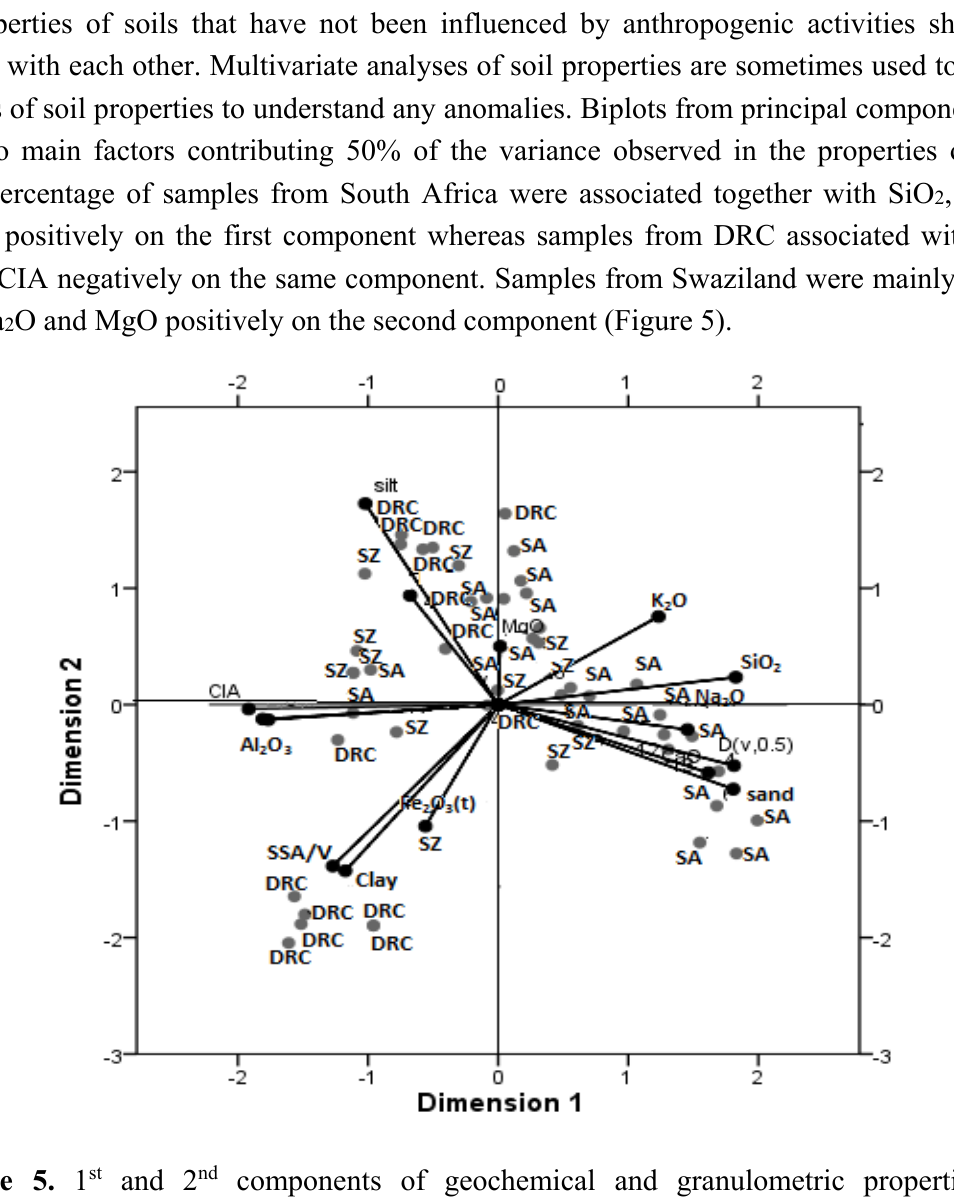
Figure 5. 1 st and 2 nd components of geochemical and granulometric properties of geophagic soil